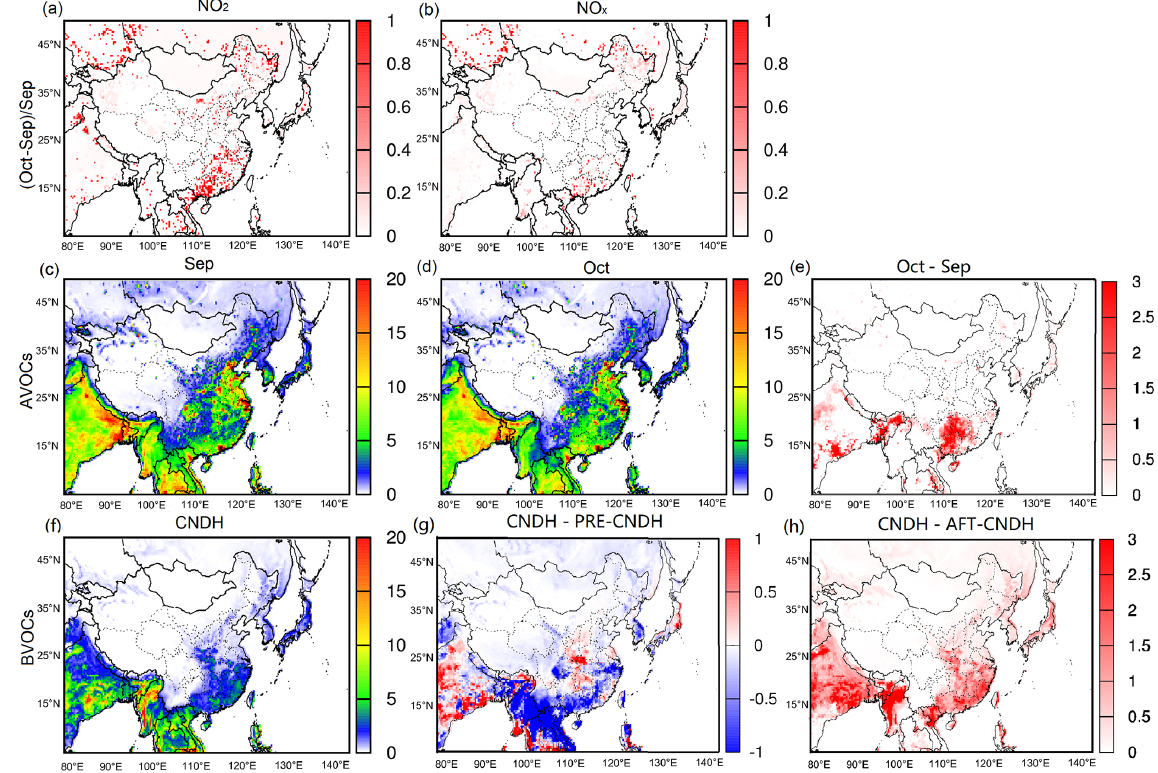
Figure 4. Changes of emissions in relative differences ((October–September)/September) of (a) NO 2 and (b) NO x . Averaged emissions rates of anthropogenic organic compounds (AVOCs) from the MEIC emission inventory in (c) September and (d) October and their difference (e) . Averaged BVOCs emission rates from the MEGAN model in (f) CNDH and their differences: (g) CNDH minus PRD-CNDH and (h) CNDH minus AFT-CNDH. Units are moles per second (moles/s) for (c) – (h)